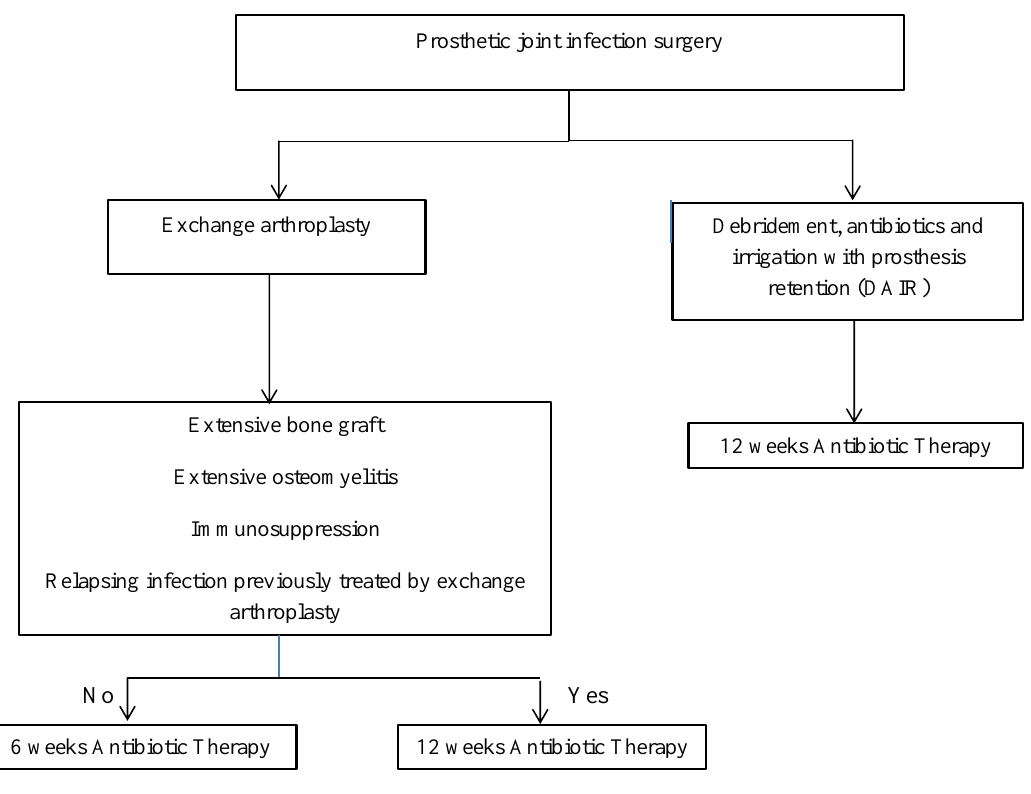
Figure 2. Duration of antibiotic